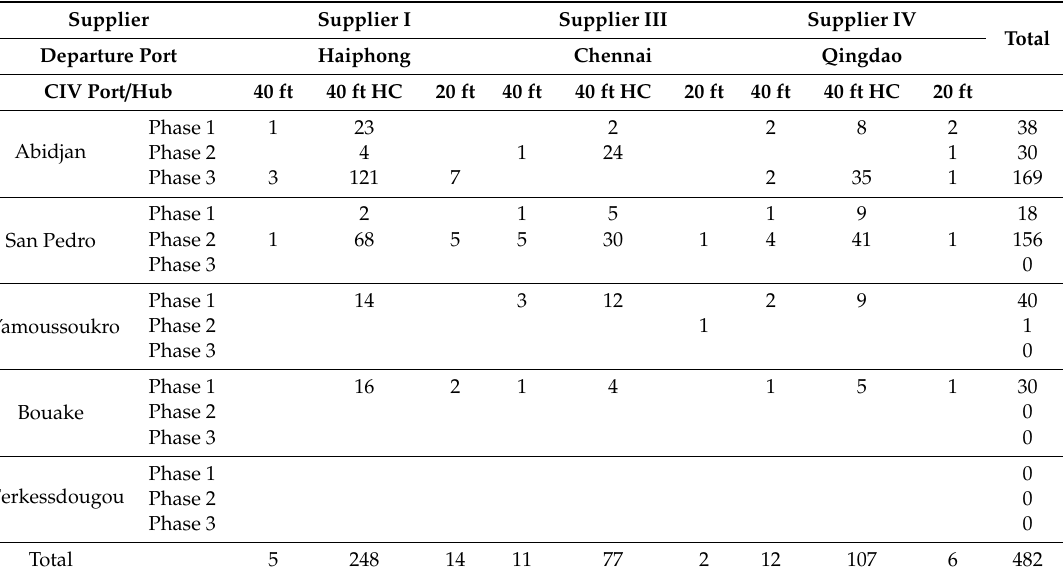
Table 1. Results of the transport from suppliers to ports at destination.